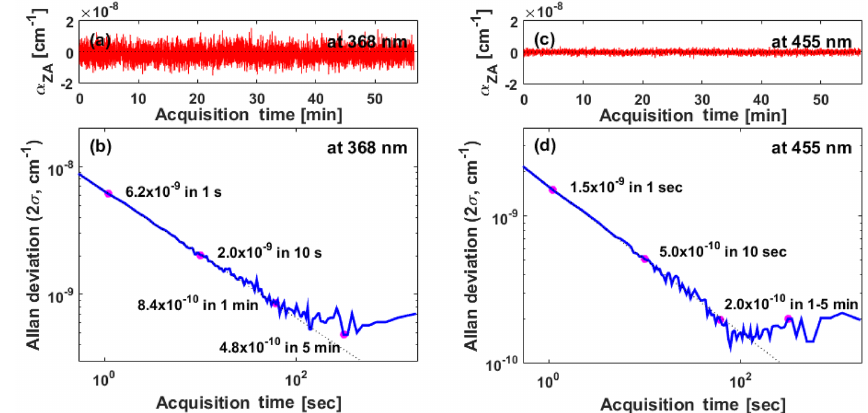
Figure 8. Allan deviation plots for single data pixels corresponding to 368nm in Ch 368 (left) and 455nm in Ch 455 (right). Extinction data were acquired for 1h in zero air at constant pressure. The dotted line indicates the relationship expected for statistically random noise. Both channels have a 2 σ precision better than 5 × 10 − 9 cm − 1 for a 10s average and are near the theoretical limits shown in Fig. 5.